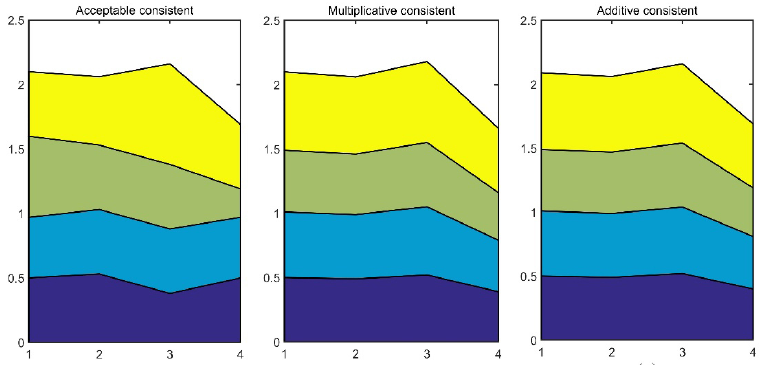
Figure 5. Areas of acceptable, multiplicative and additive consistent DHHFLPR of